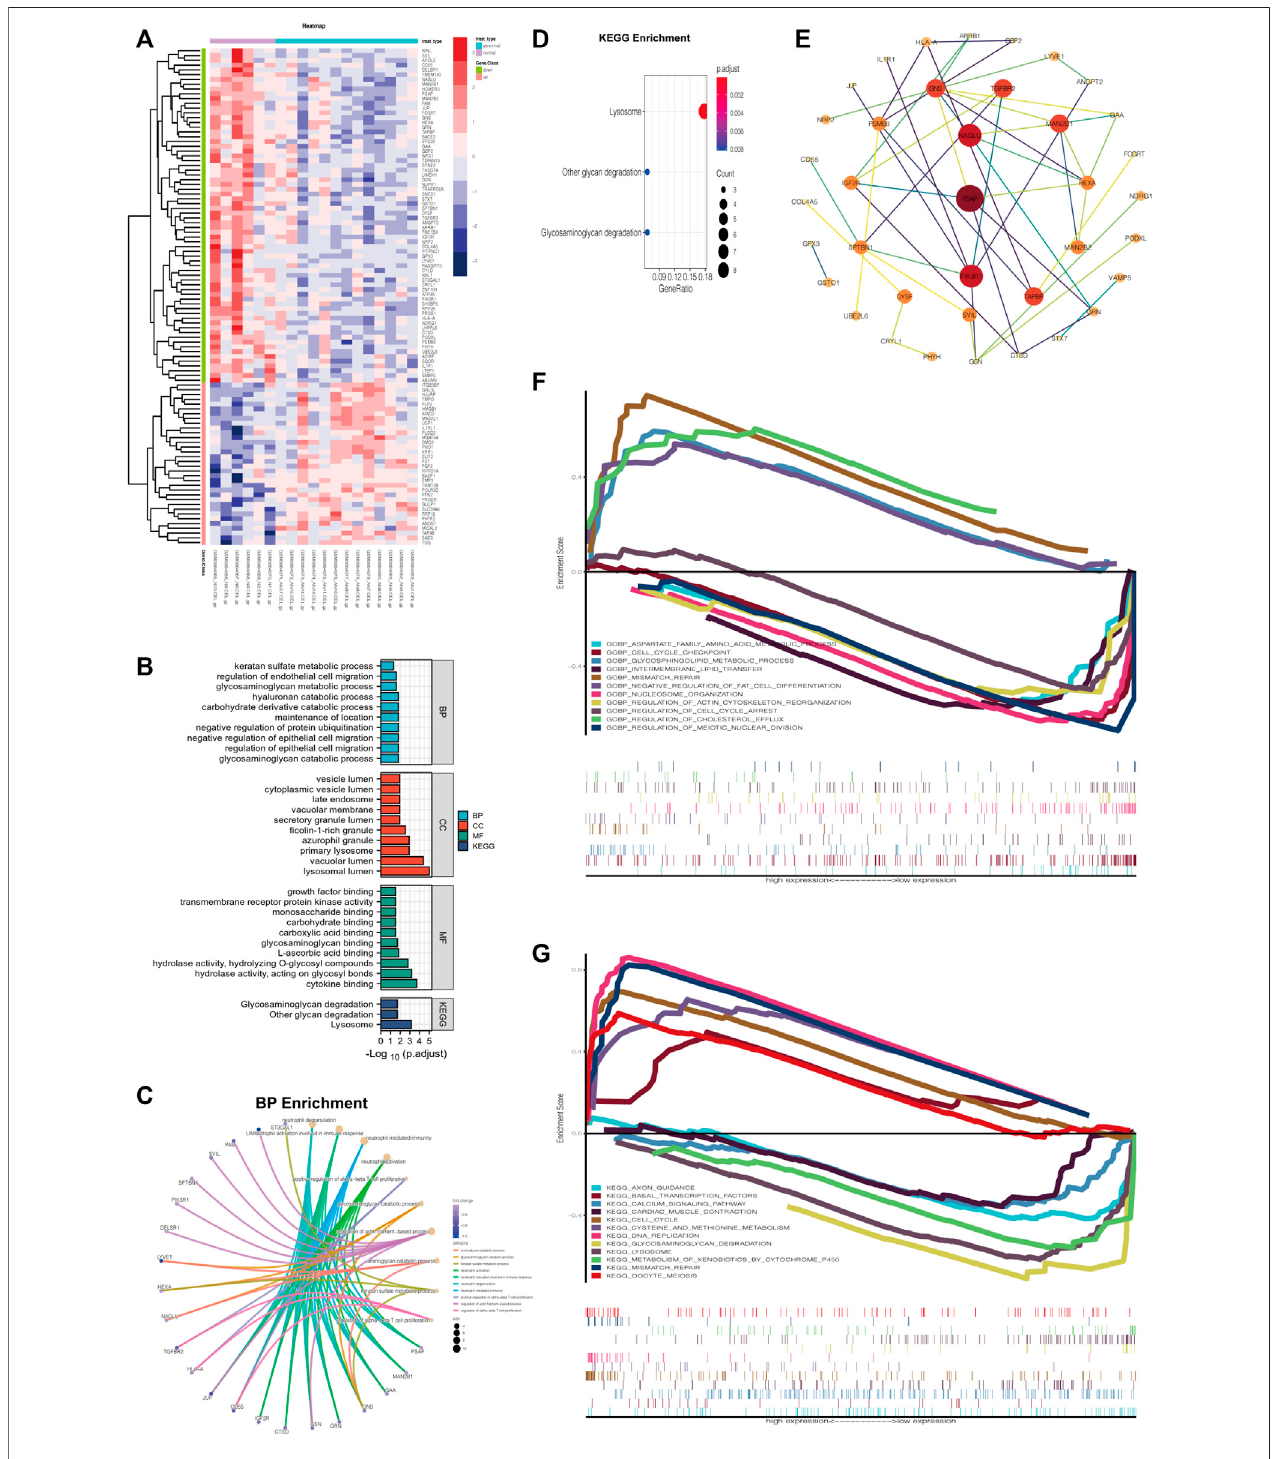
FIGURE 3 | Aberrant gene expression pro fi ling and functional annotation enrichment analyses. (A) Heatmap of aberrant gene expression pro fi ling. (B) GO (includingBP,CC,andMF)andKEGGanalysesofaberrantgeneexpressionpro fi ling. (C) GOBPenrichmentofDRGsusingR. (D) KEGGpathwaysenrichmentofDRGs using R. (E) Construction of the PPI network of DRGs via Cytoscape software. (F) Multiple GSEA of varied expression of NAGLU using GO BP analysis (c5). (G) Multiple GSEA of varied expression of NAGLU using KEGG analysis (c2).